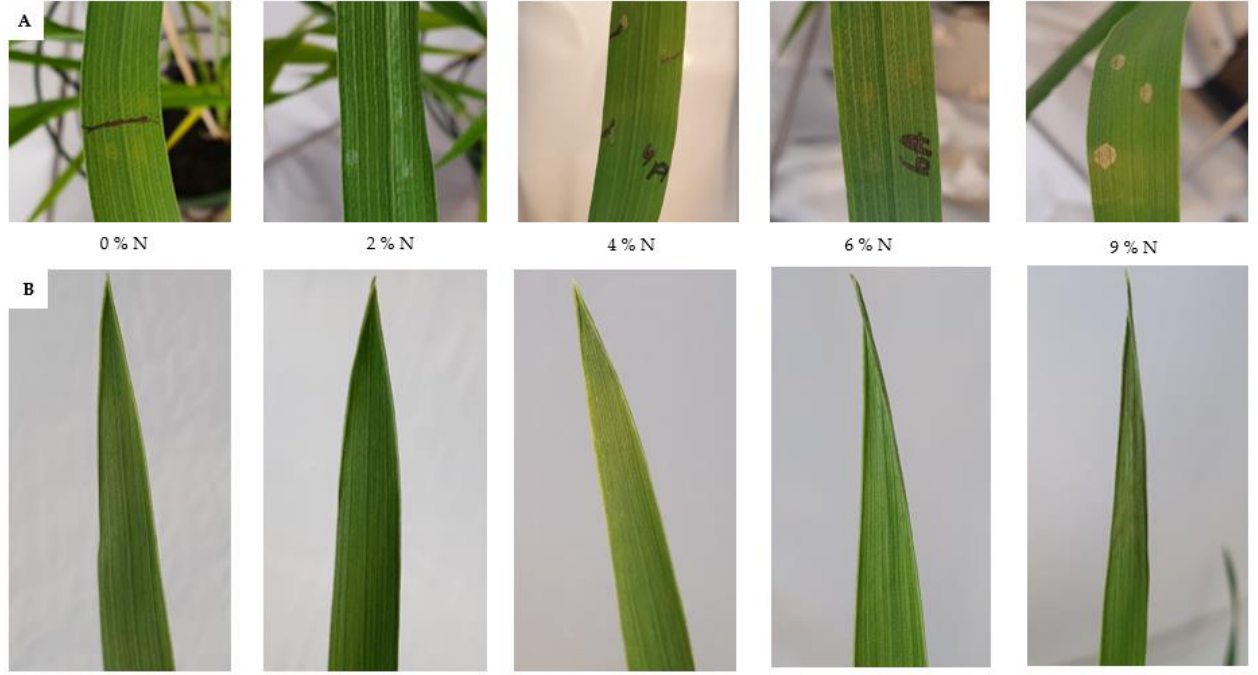
Figure 2. Nitrogen toxicity occurring 1 day after the application of urea solution with surfactant onto the YFEL of wheat (cv. Harenda). Three droplets of 3 µL urea solution with a concentration of 0, 2, 4, 6 or 9% N were pipetted onto the middle section of the adaxial surface of the YFEL. ( A ) Scorching underneath the droplets; and ( B ) scorching at the tip of the leaf.